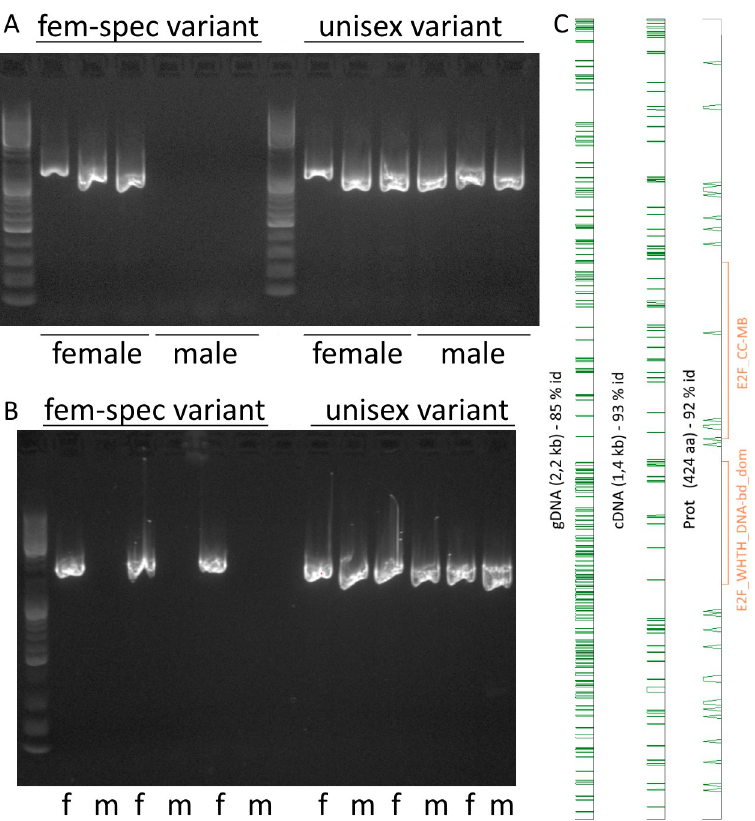
Fig 5. Sex-specific variants of E2F transcription factor EMLSAG00000007877. Primers targeting the CDS of the female-specific variant and the unisex variant were used in PCR of female (f) and male (m) samples. A. cDNA. B. genomic DNA. C. Alignment of the two variants on gDNA, cDNA, and deduced protein level. 5’-end/N-terminus are at the bottom of the graphs. Green marks mark differences between the female-specific and unisex variants. Conserved Interpro-domains are marked in orange in the protein